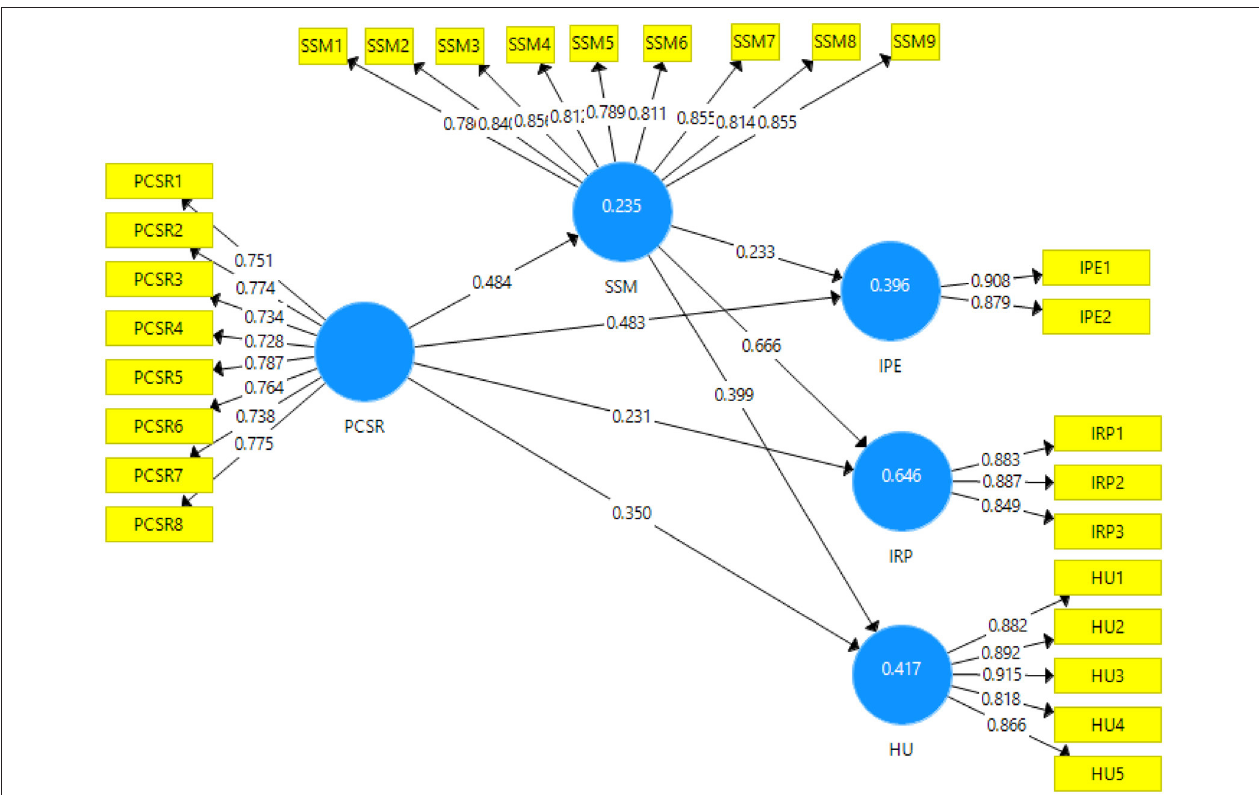
FIGURE 2 | Output of measurement model. PCSR, Perceived Corporate Social Responsibility; IPE, Injury Prevention Expectation; IRP, Injury Risk Perception; HU, Health Up Gradation; SSM, Sports Safety Measures.